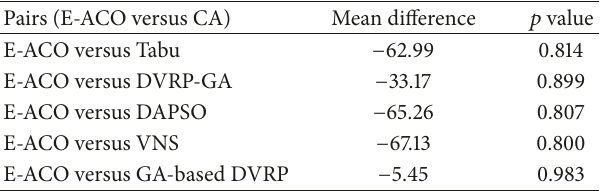
Table 9: Paired 𝑡 -test based on the published systems. Pairs (E-ACO versus